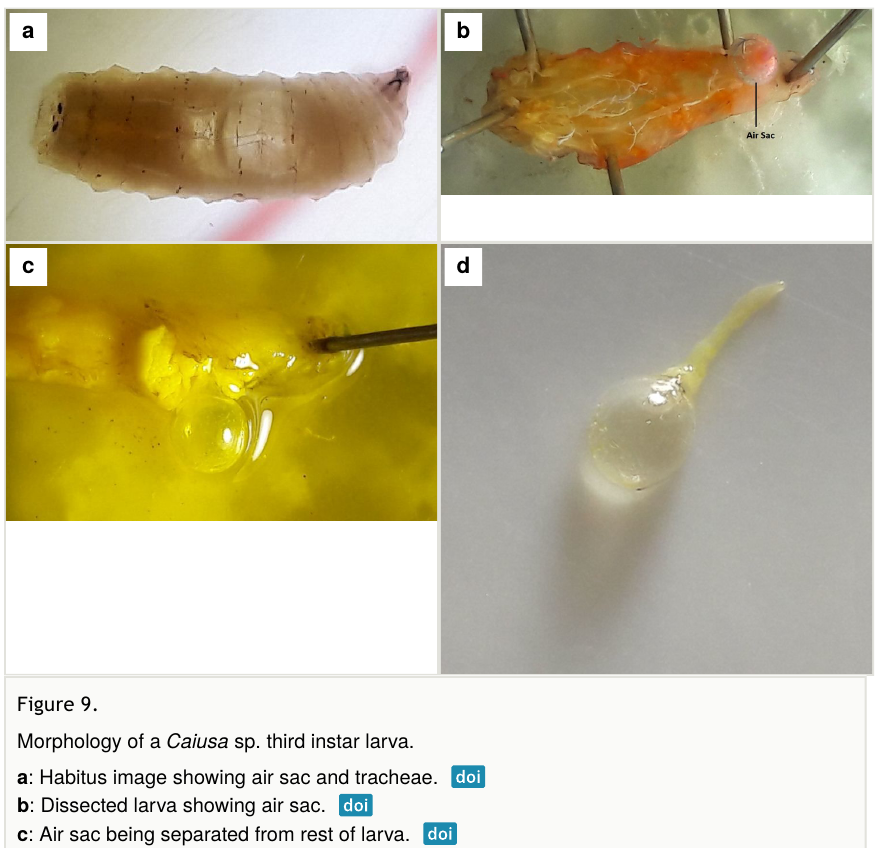
Morphology of a Caiusa sp. third instar